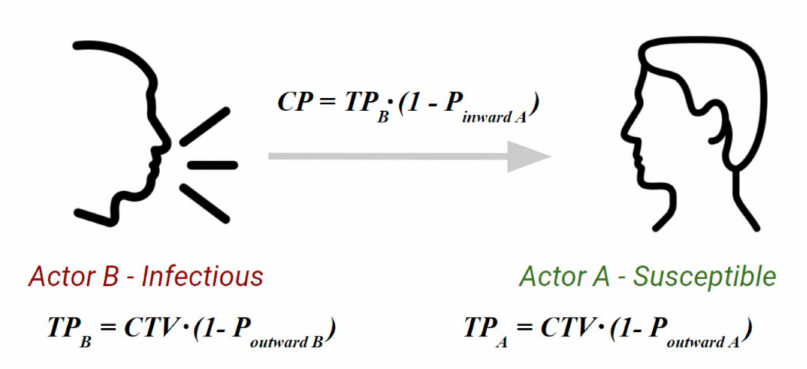
Figure 2. Stochastic contagion